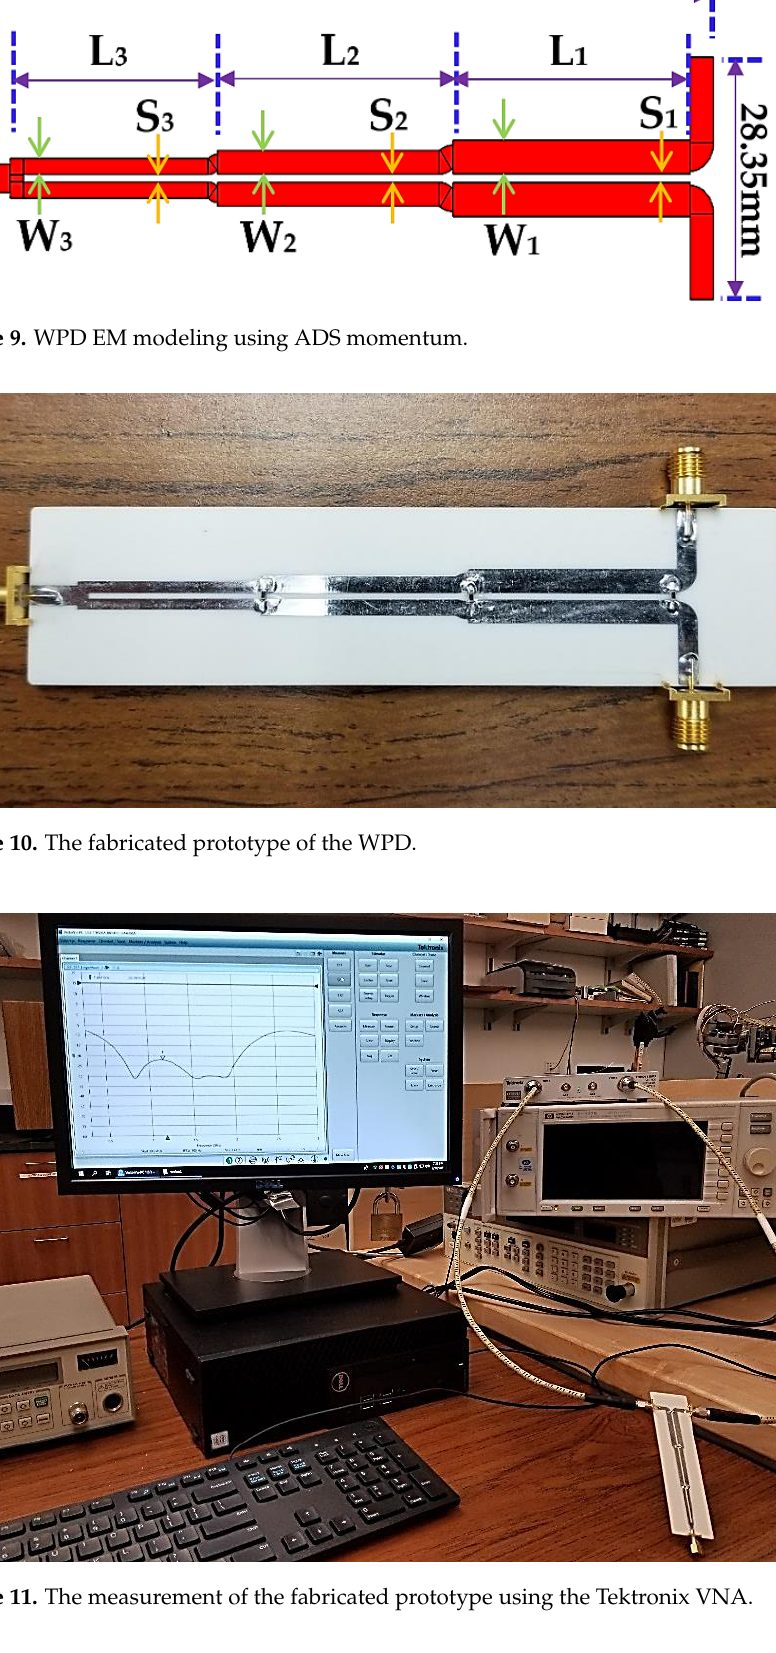
Figure 11. The measurement of the fabricated prototype using the Tektronix VNA. It is apparent from Figure 12a,b that the designed prototype has excellent reflection parameters maintaining an input return loss greater than 16.4 dB and an output return loss greater than 15 dB throughout the band from 0.595 GHz to 2.05 GHz. Besides, the transmission parameters are also found to demonstrate decent performance in Figure 12c ensuring an insertion loss of lesser than 3.30 dB, not far from the ideal 3 dB value in the aforesaid band. Moreover, as shown in Figures 12d and 13, the measured isolation and phase imbalance of 22 dB (minimum) and value of 0.02 degrees (maximum), respectively, are remarkable. From the aforesaid band, the measured % FBW is 110% considering the −15dB reference line whereas it becomes 141% considering a −10dB reference level from 0.41 GHz to 2.37 GHz, which is outstanding.